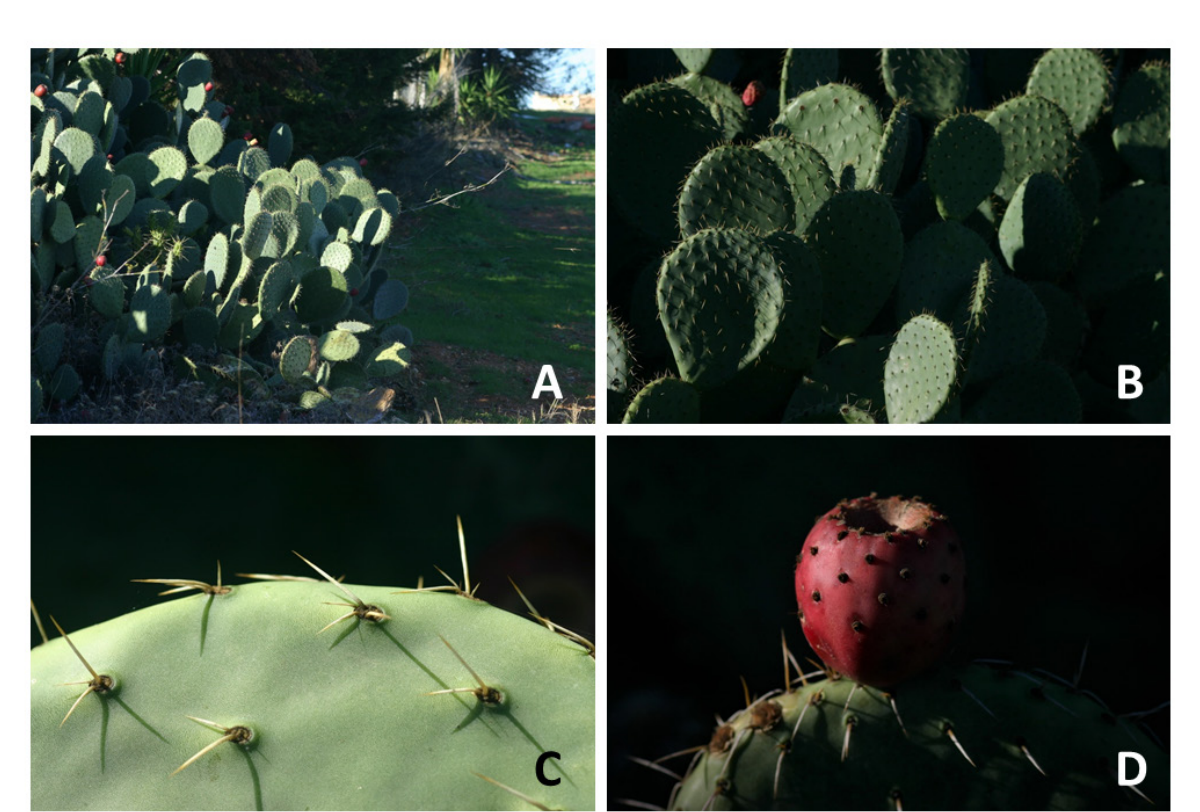
Figure 1. Opuntia streptacantha . Ayamonte, November 2018, E. Sánchez Gullón. A) Habit; B) Detail of stem segments; C) Detail of spination; D) Detail of